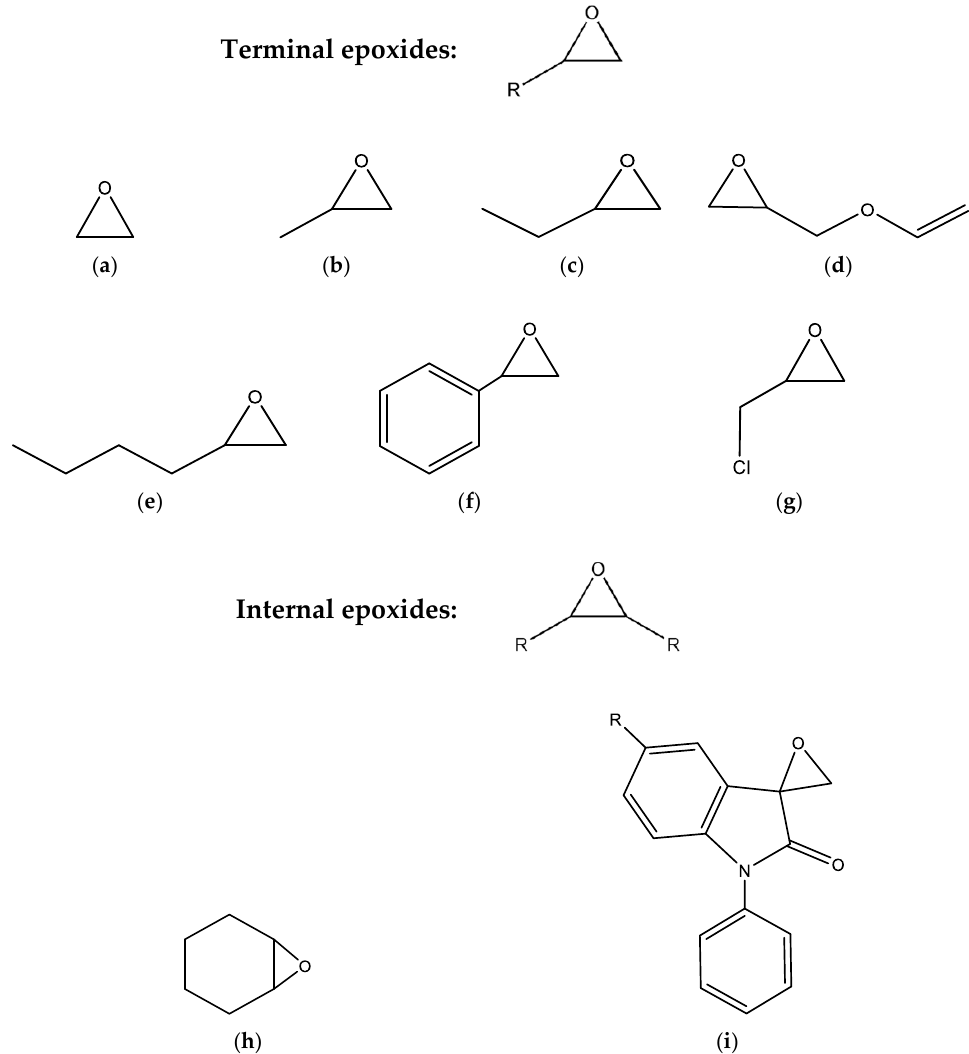
Figure 3. Structure of typical and some emerging epoxide species: ( a ) ethylene oxide (EO); ( b ) propylene oxide (PO); ( c ) butylene oxide (BO); ( d ) allyl glycidyl ether (AGE); ( e ) hexene oxide (HO); ( f ) styrene oxide (SO); ( g ) epichlorohydrin (ECH); ( h ) cyclohexene oxide (CHO); ( i ) spiro-epoxy oxindole (SEO).